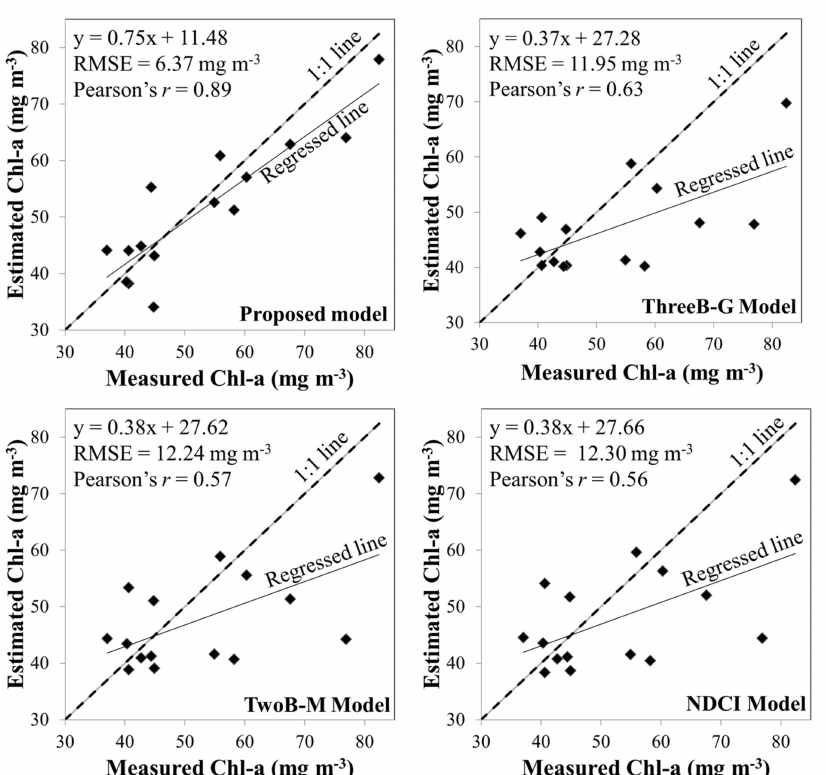
Figure 4. Comparison between estimated and measured chlorophyll-a (Chl-a) concentration provided by compared models in OptiM-3, ThreeB-G, TwoB-M, and NDCI